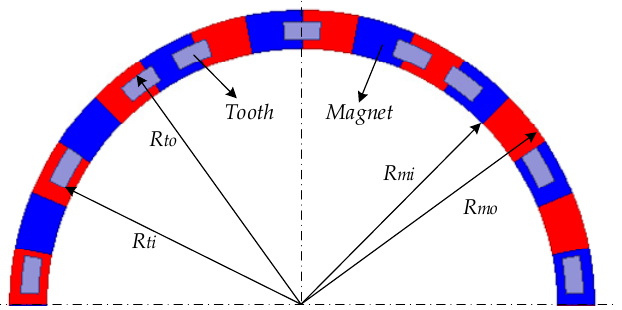
Figure 2. Top view of half proposed AFPMVM.